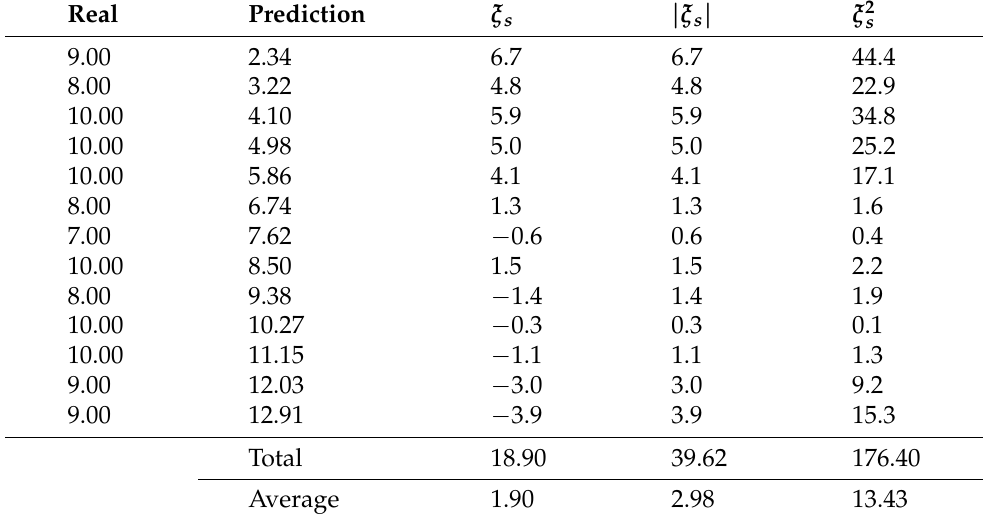
Table 6. Details of the estimations.